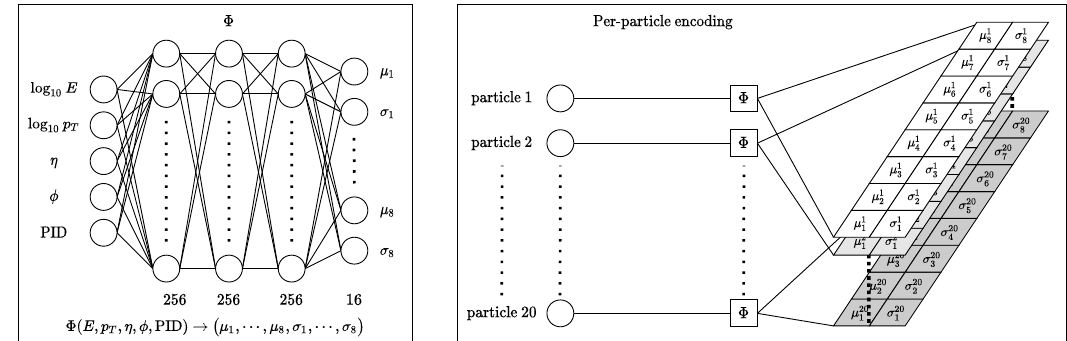
Figure 1: The left panel displays the network Φ which takes as input the four-vector and particle identification of a particle and maps it into the latent space. The right panel shows that how this is done for each particle in the event. We use a featurewise sort pooling layer to combine the per-particle latent space into an event-level representation as shown in Eq.